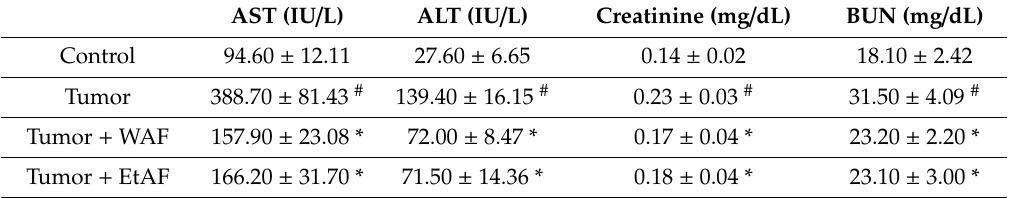
Table 2. Cytotoxicity of WAF and EtAF on serum levels in mildly induced cachexia mice.